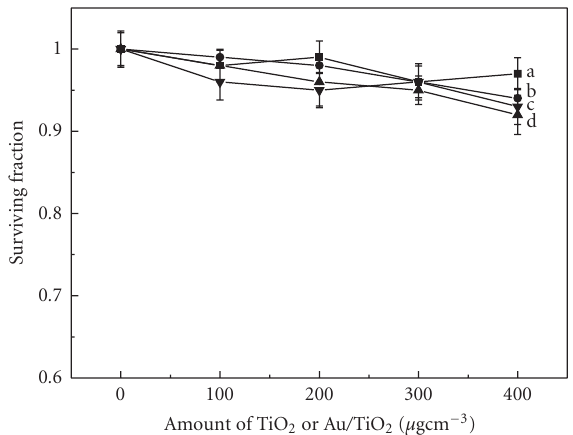
Figure 3: Surviving fraction of LoVo cells as a function of ir- radiation time after being incubated in culture medium contain- ing 50 μ g/mL Au / TiO 2 nanocomposites with di ff erent Au ratio: (a) 0 wt%, (b) 1 wt%, (c) 2wt%, and (d) 4wt%. The wavelength of UV light is 365 nm, and the intensity is 1.8mW/cm 2 . Bars represent the region of measured data and the points represent the mean value from three